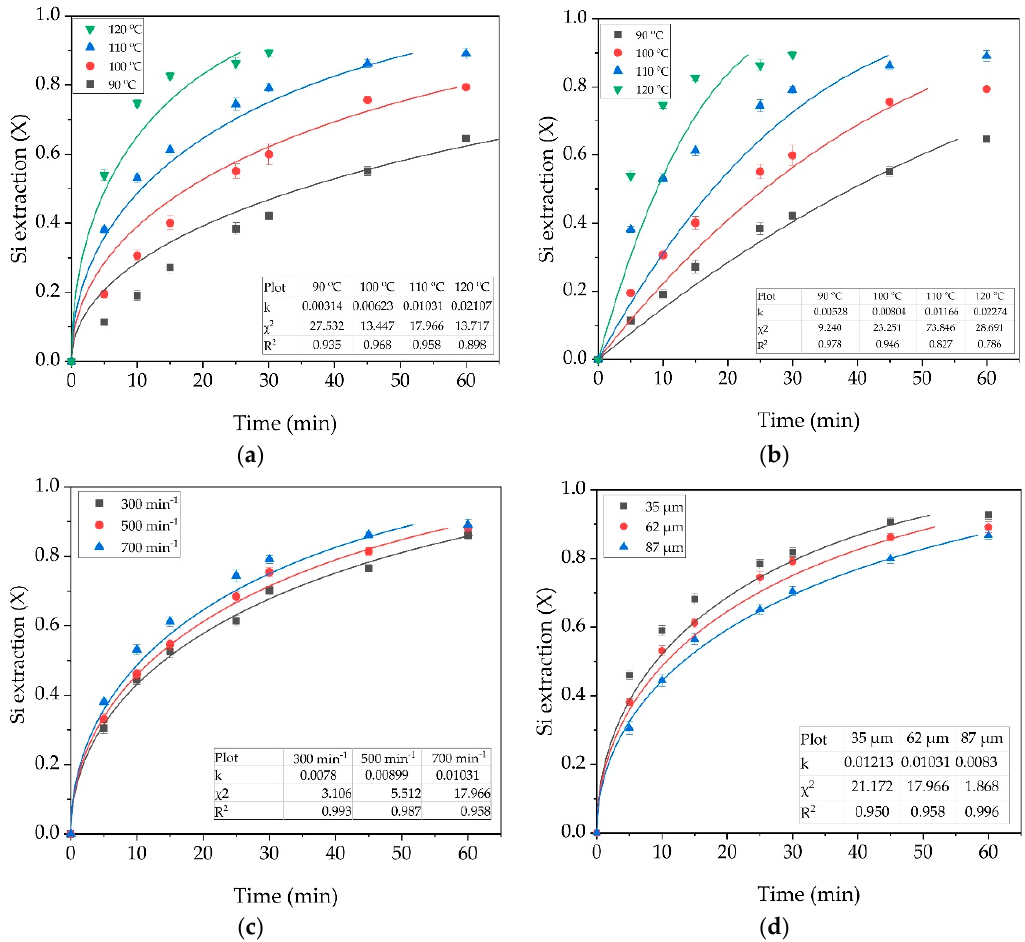
Figure 5. The results of fitting experimental data (points) by the shrinking core model (lines): the diffusion through the liquid film ( a ); the surface reaction for the effect of temperature ( b ); ( c ) the diffusion through the liquid film for the effect of stirrer rate; and ( d ) the diffusion through the liquid film for the average particle size.